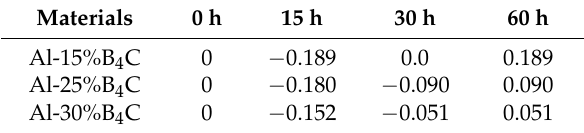
Table 2. Mass increment rate of Al/B 4 C MMCs during the corrosion ( ∆ wt